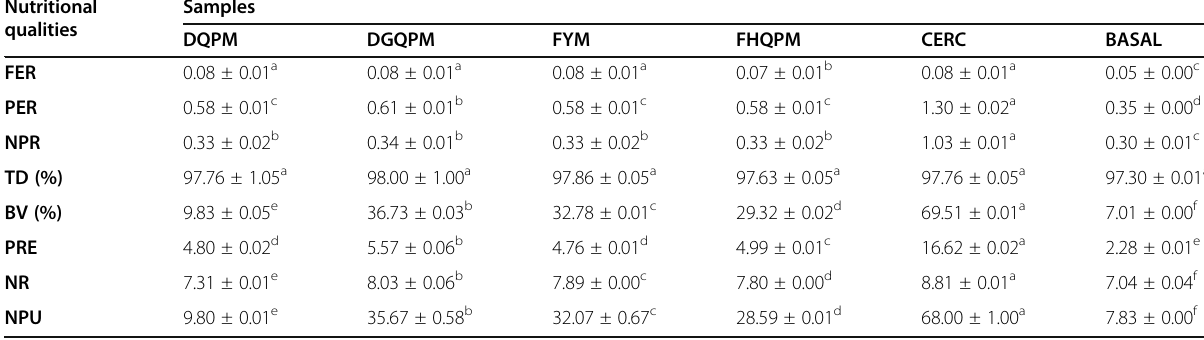
Table 4 Nutritional quality of blend of maize and almond seed flours Nutritional Samples qualities